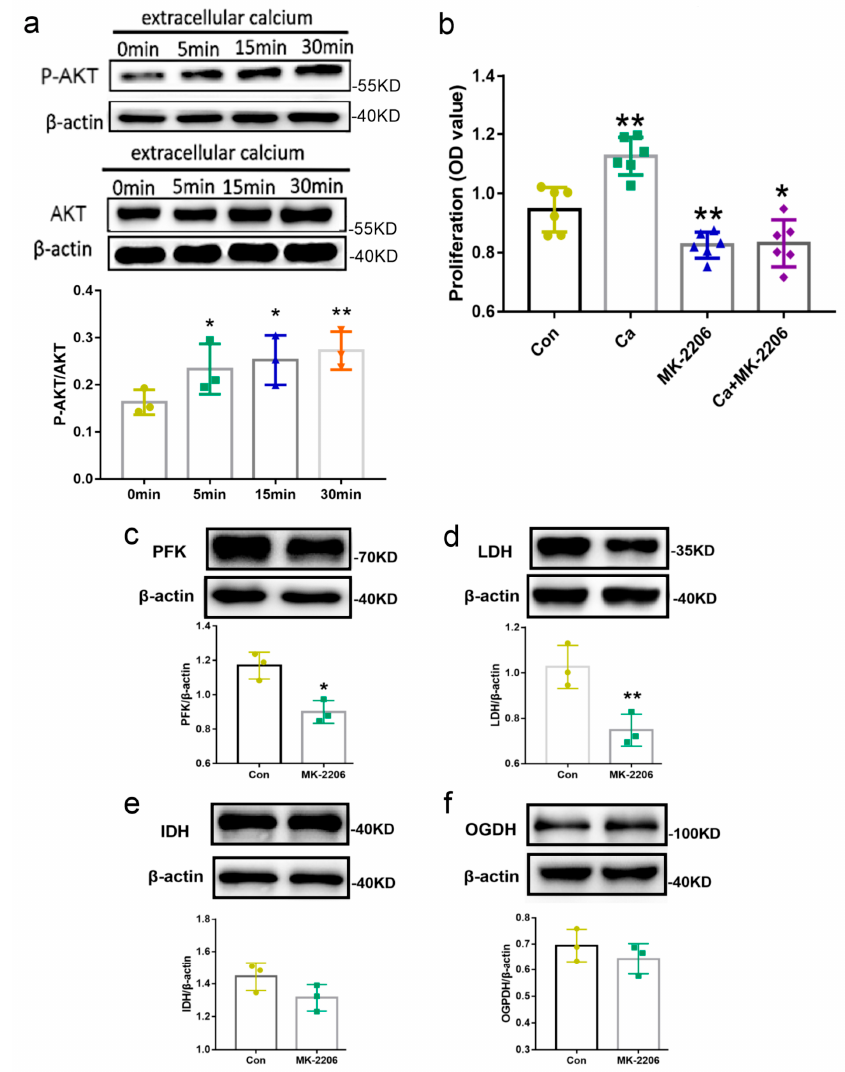
Figure 5. AKT was involved in regulation of energy metabolism. ( a ) Extracellular 7.2 mM Ca 2+ induced changes of p-AKT and AKT. ( b ) The osteoblasts proliferation treated with 7.2 mM calcium, 1 µ M MK-2206, and both of them, ( c – f ) Effects of 1 µ M MK-2206 and extracellular 7.2 mM Ca 2+ on PFK and LDH, IDH and OGDH. * p < 0.05, ** p < 0.01 vs. Con. 2.6. Extracellular Calcium Induces Intracellular Ca 2+ Transients Which Rely on Calcium-Sensing Receptor (CaSR) in Osteoblasts